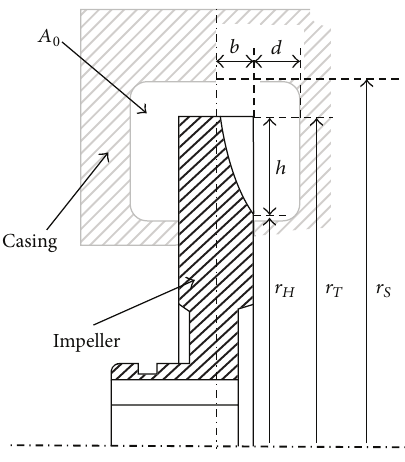
Figure 2: Regenerative pump geometric